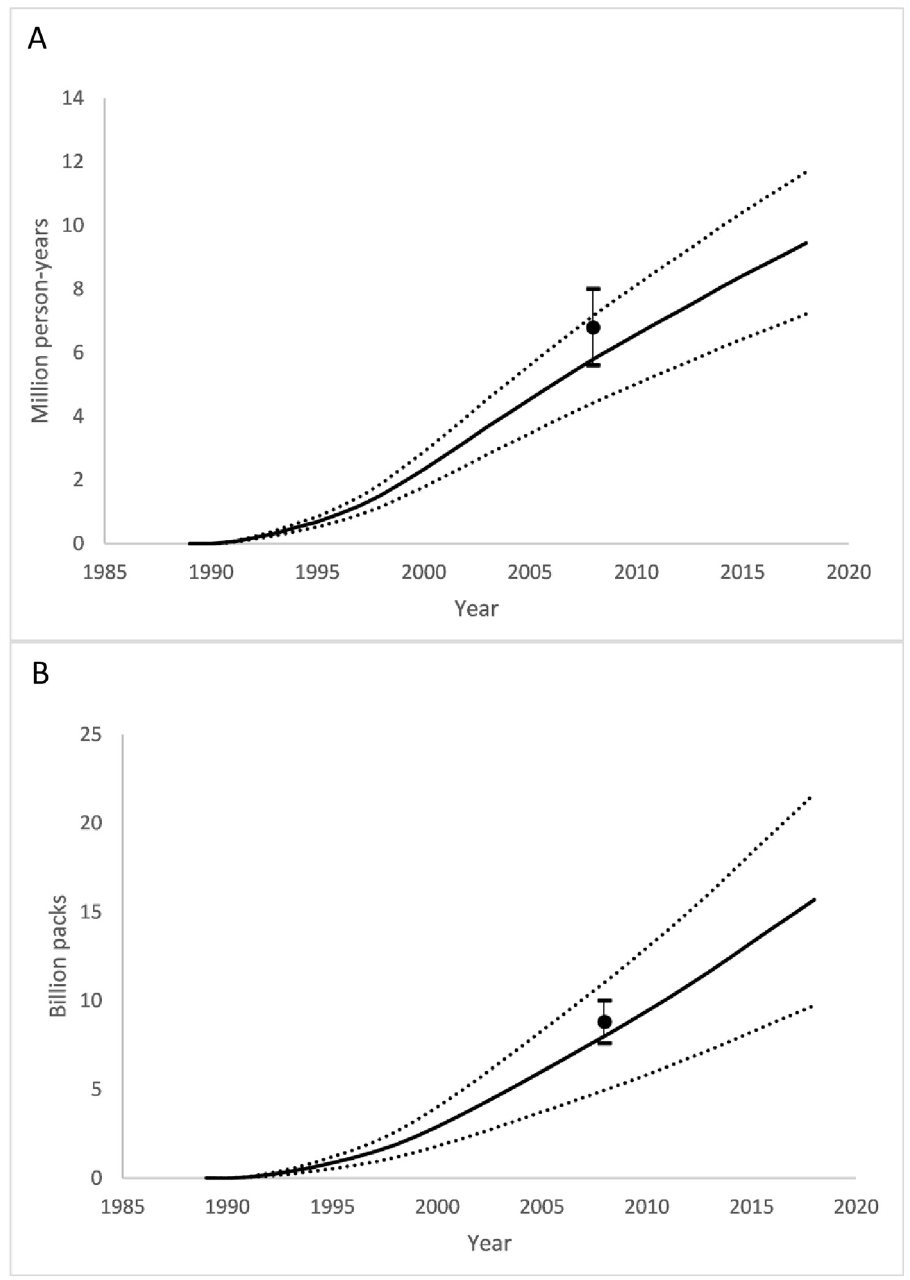
Fig 2. Cumulative reductions in smoking attributable to the CTCP. (A) Person years of smoking. (B) Packs of cigarettes. Black line: mean; Dotted lines: lower and upper 95% confidence intervals for prediction; Black dots and error bars: point and 95% confidence interval reported in ECTCP [4] 2013